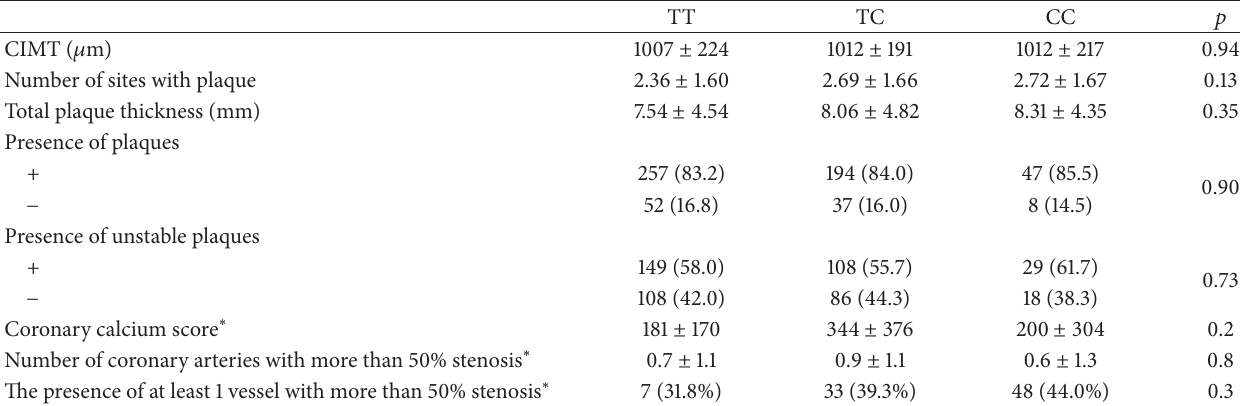
Table 4: Ultrasonographic markers of carotid atherosclerosis due to rs8192673 genotypes in patients with T2DM at the time of recruitment.